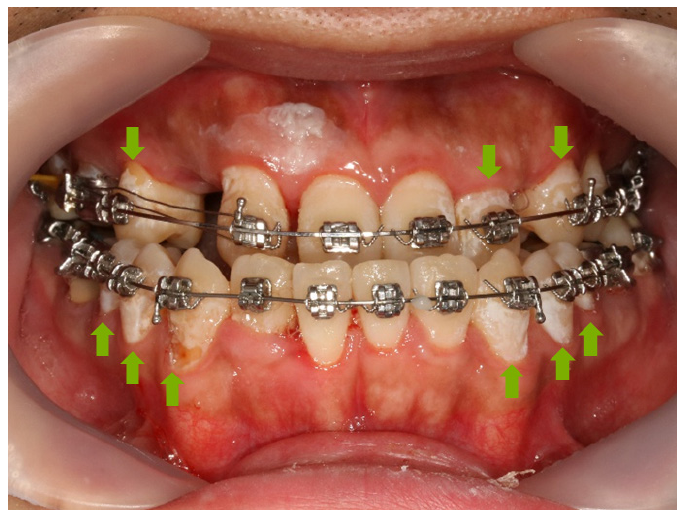
Figure 1 . The WSL on orthodontic patient. Green arrow indicates WSL on tooth. Figure 1. The WSL on orthodontic patient. Green arrow indicates WSL on